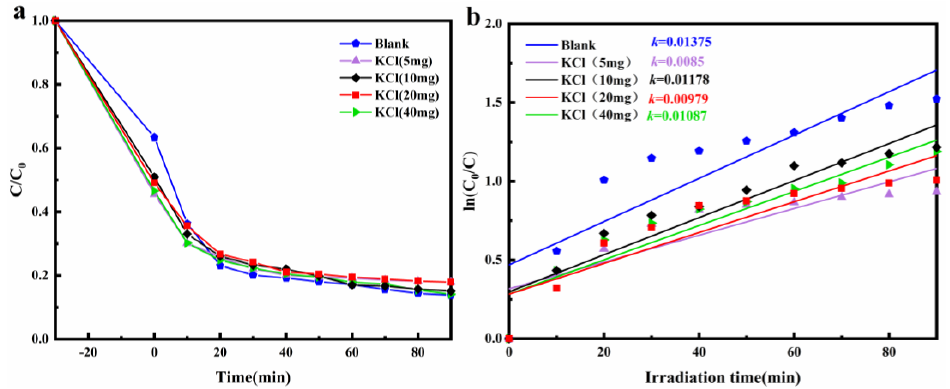
Figure 7. Photodegradation rates of TC (10 mg/L) in solutions containing ZnO@Bi 5 O 7 I (2:1) and different concentrations of KCl. ( a ) C/C 0 vs. time, ( b ) ln(C/C 0 ) vs. time.